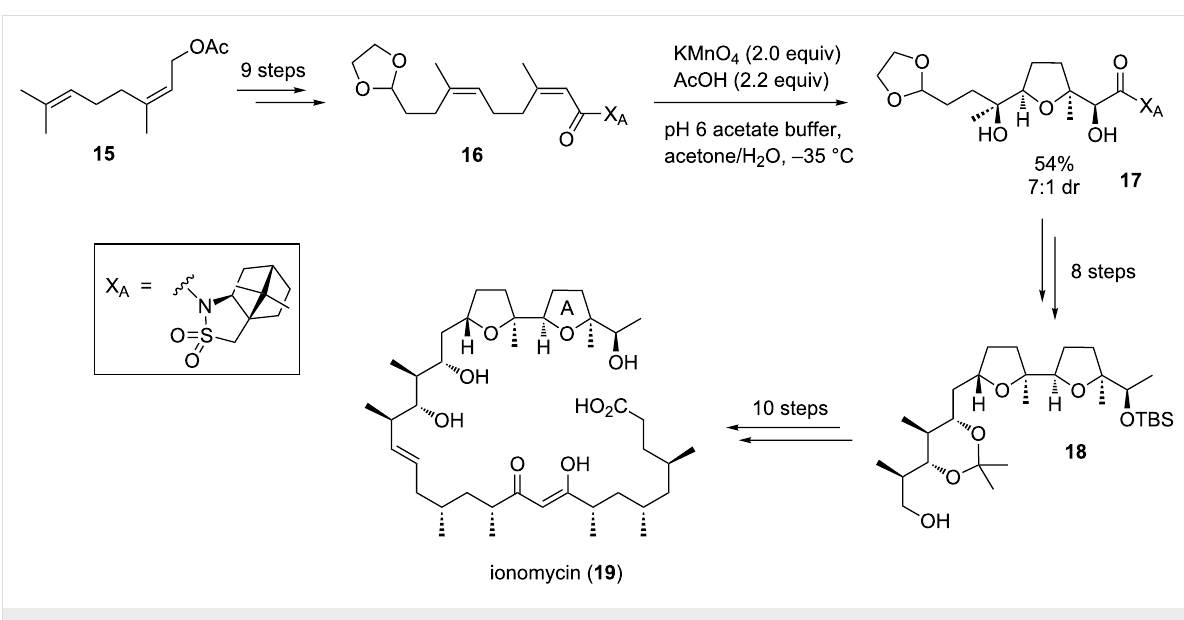
Scheme 6: Formal synthesis of ionomycin by Kocienski and